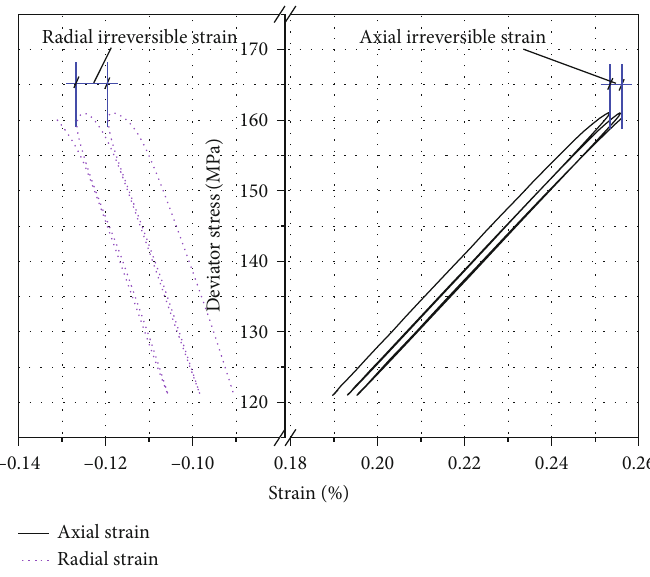
Figure 9: Calculation diagram of irreversible